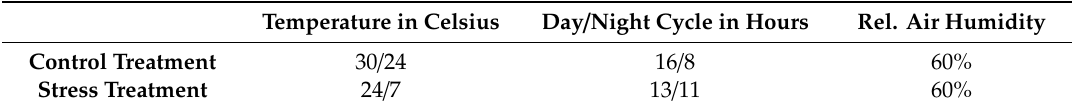
Table 2. Settings of the climate chamber